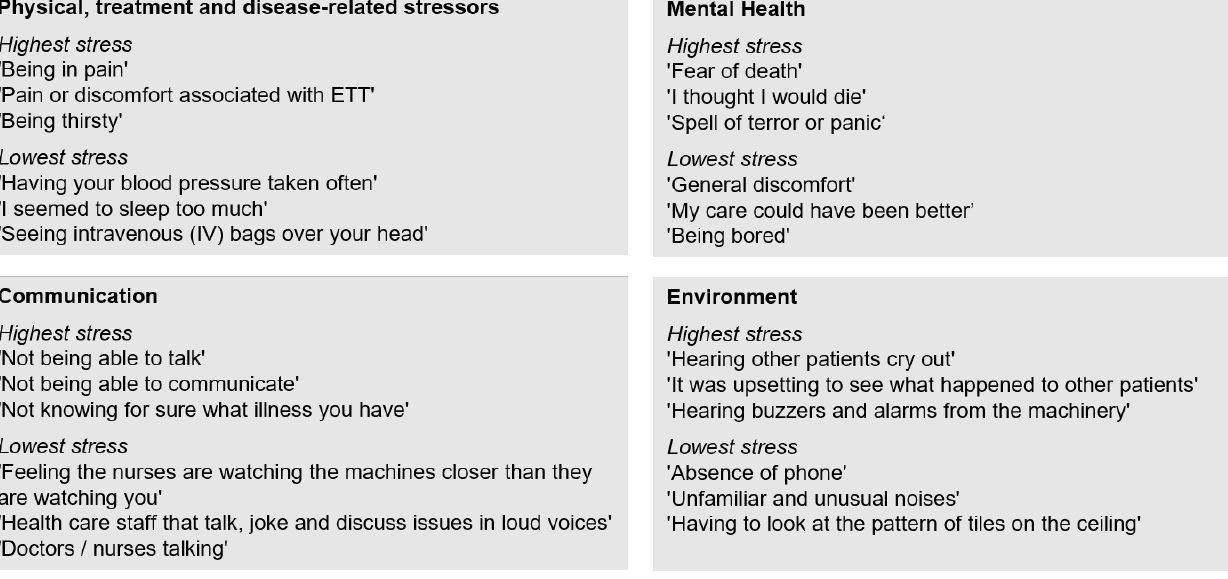
Figure 2. Summary of the results of the systematic review. Table 2. Synthesis of perceived severity of stressors in the ICU: Ranking lists of four stressor domains according to mean scores of severity rankings of four clinical ICU experts. +